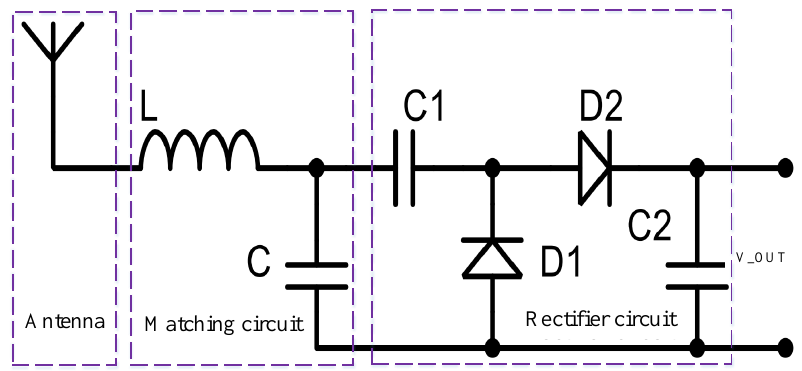
Figure 5. The principle of harvesting RF energy system.